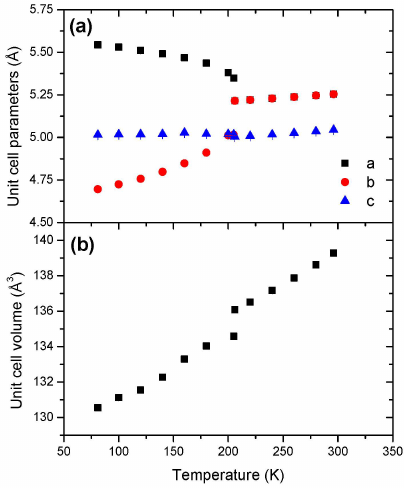
Figure 2. Temperature dependence of ( a ) the unit cell parameters and ( b ) the unit cell volume of AB within the range of temperature 81–301 K. Table 1. Crystal phase, space group (s.g.), temperature T (K) at which the structure was determined, formula unit Z and unit cell parameters of the